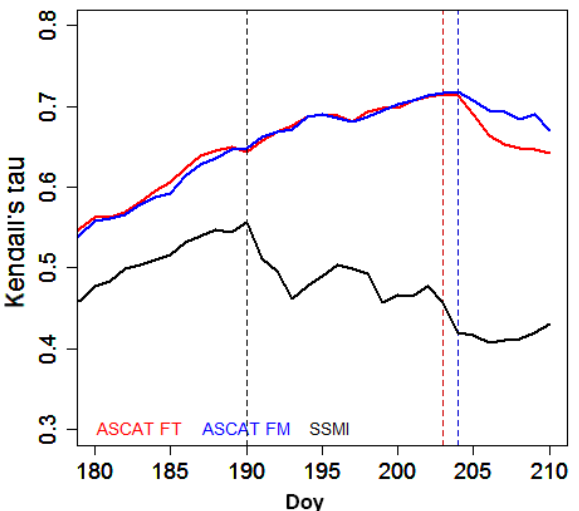
Figure 13. Curves of correlation coefficient (Kendall’s τ ) between 180 and 210 days per year (doy) frozen from satellite products and positive or negative MAGT c at the depth of the coldest sensor from borehole data. FT – days identified as frozen without melting snow are used; FM – days with melting snow are considered to be frozen ground with Metop